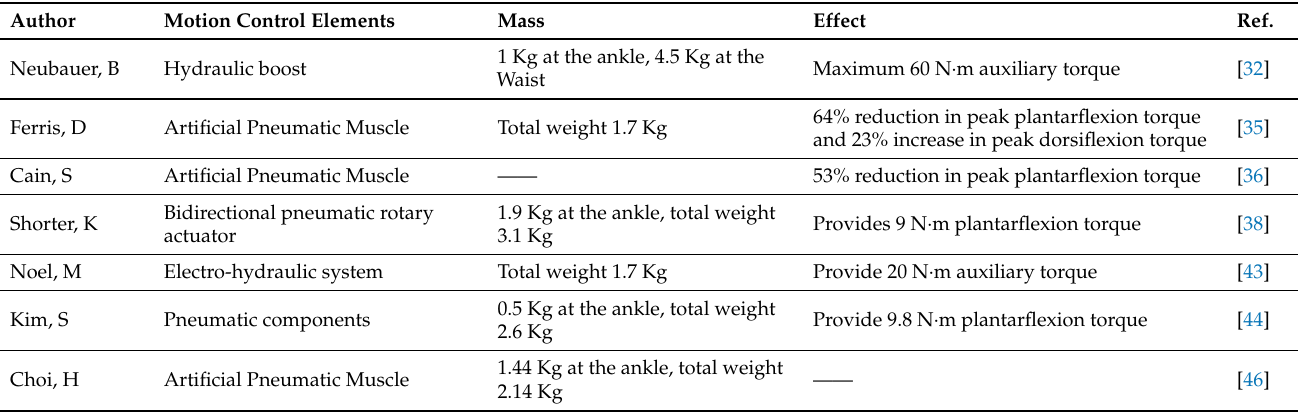
Table 3. Comparison of AAFOs in mass and